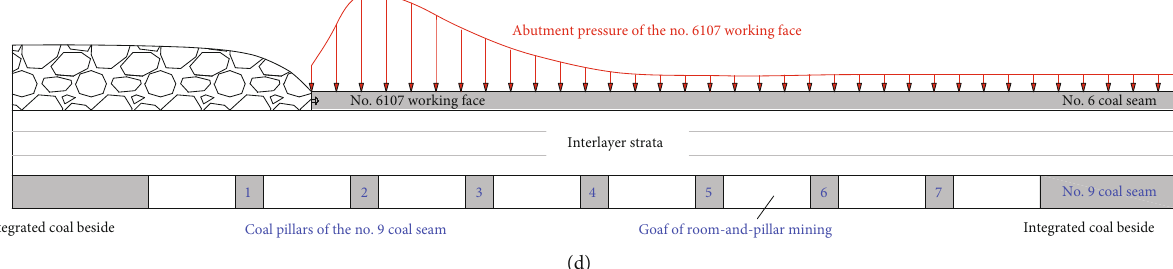
Figure 1: The location of the Yuanbaowan coal mine and the schematic diagram of mining above the goaf: (a) roof pillar; (b) fl oor pillar; (c) geographic location; (d) schematic diagram of no. 6107 working face mining above the goaf.